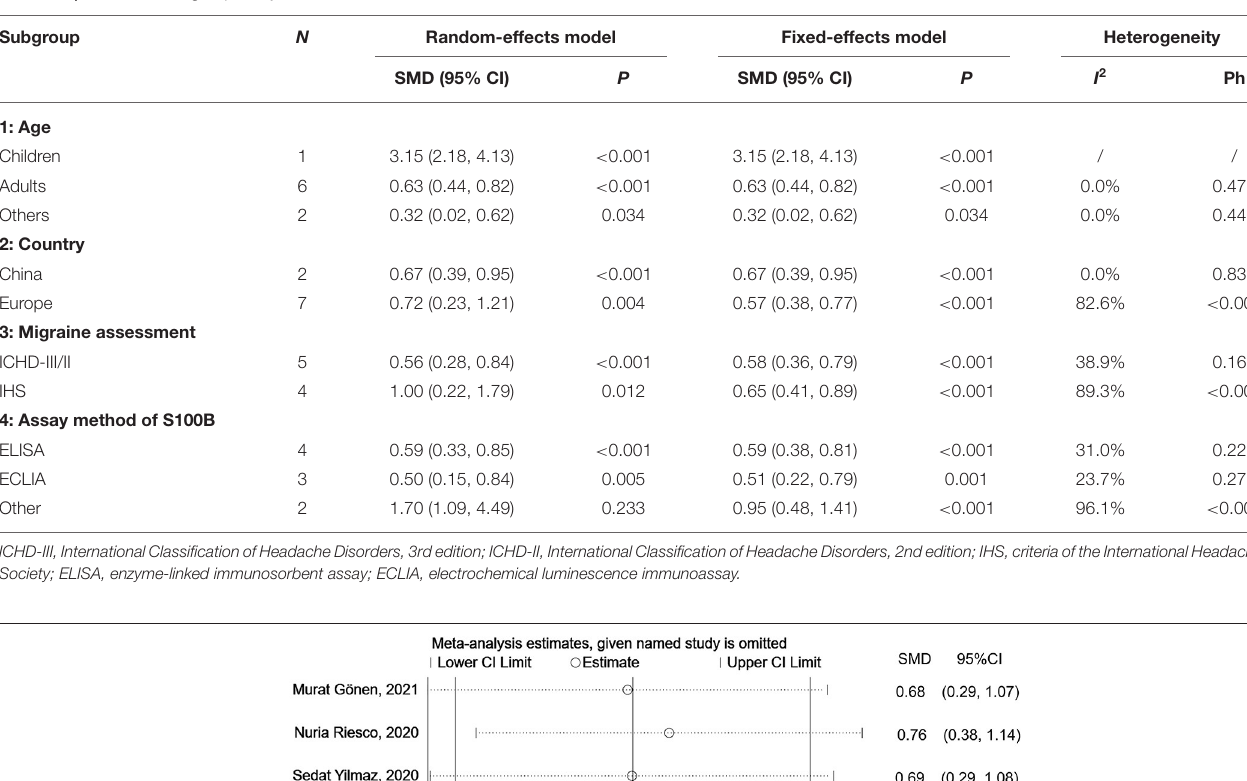
TABLE 4 | Results of subgroup analyses.